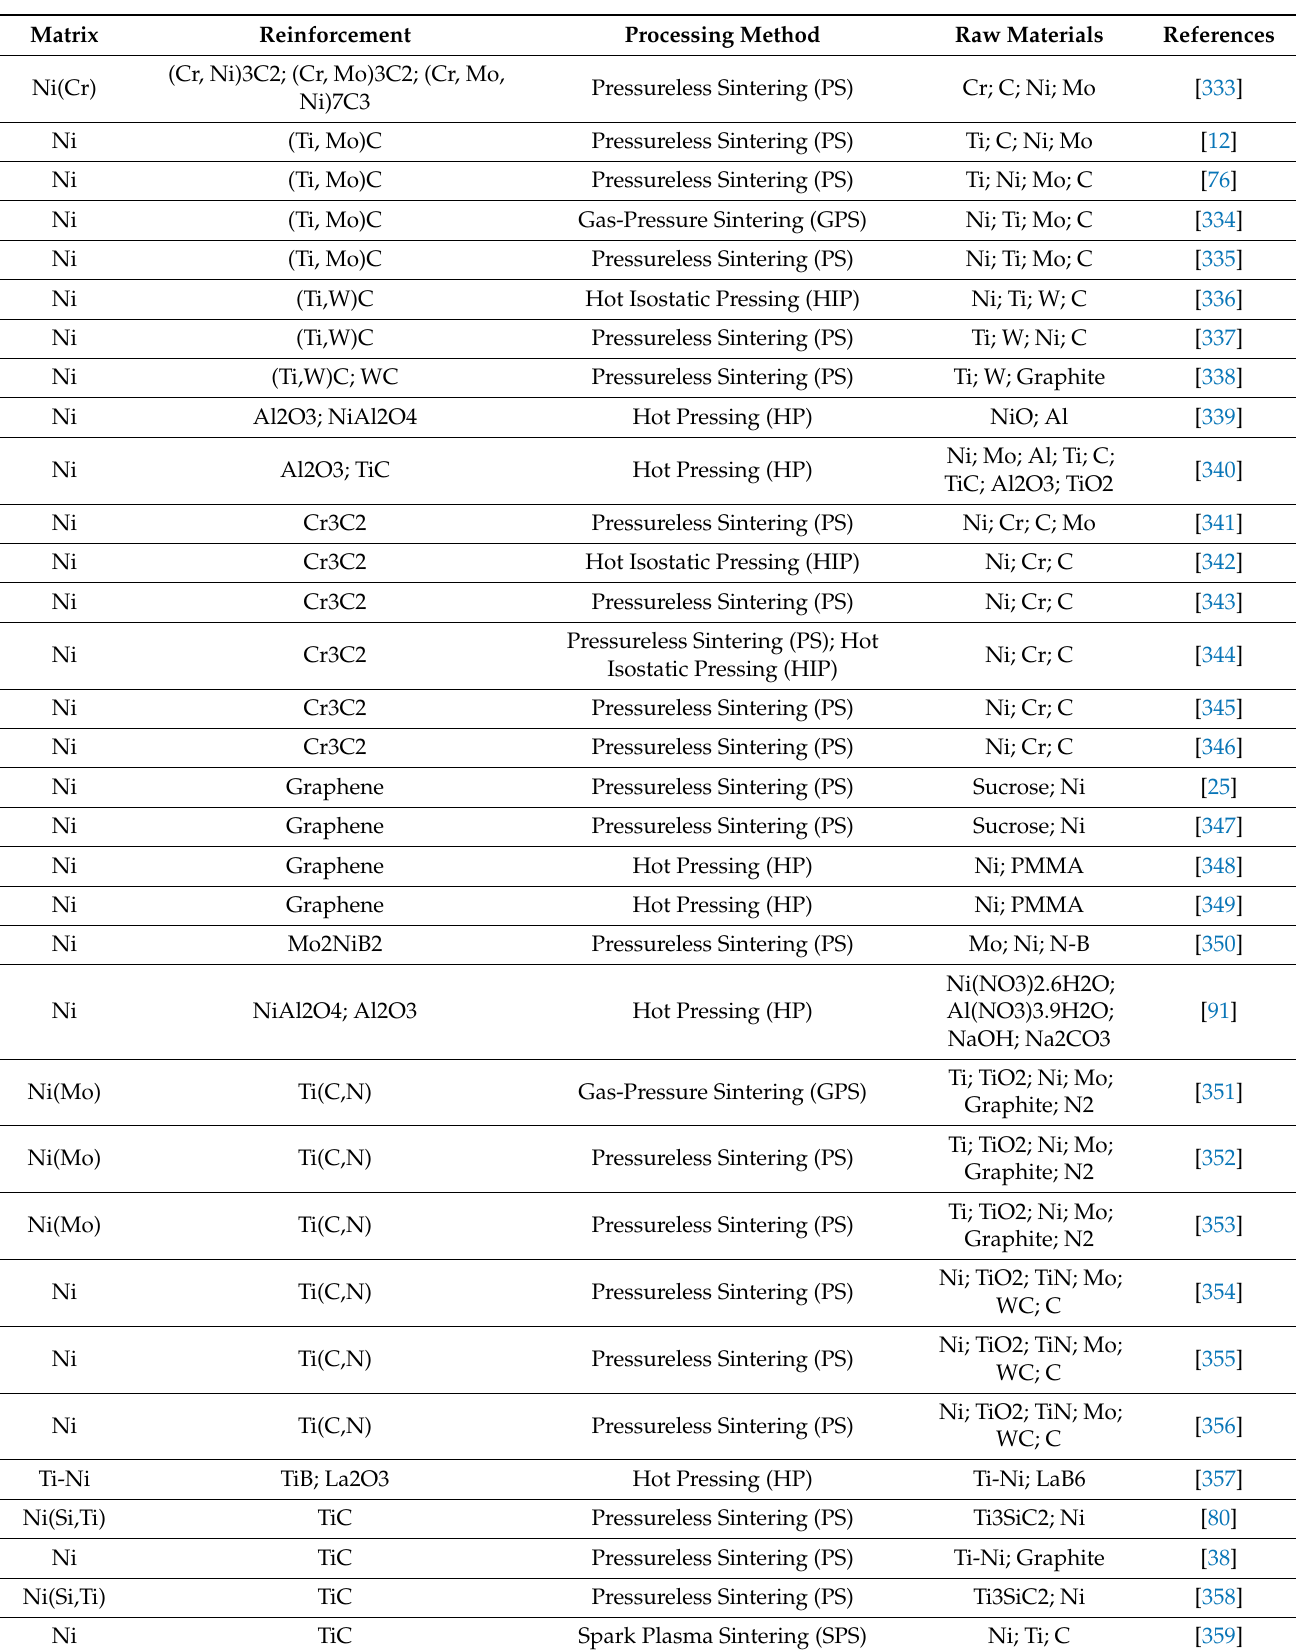
Table A4. Nickel Matrix